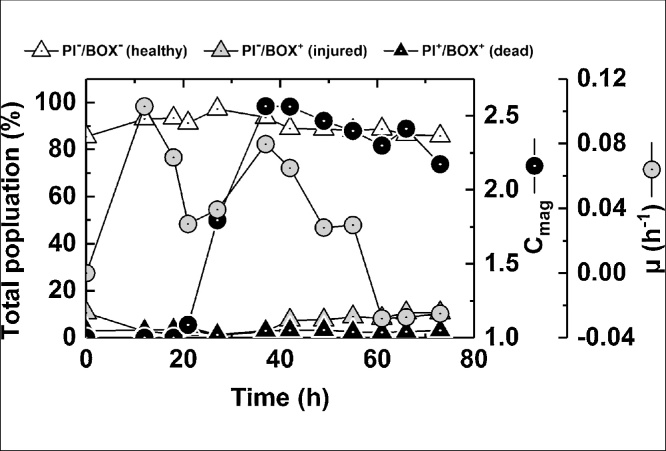
Assessment of bacterial physiology using FCM. Bacteria from an oxygen-limited pH-stat culture with 200 g·L−1 lactic acid and 6 g·L−1 sodium nitrate in the feed were stained with PI and BOX and analyzed by FCM. The percentages of cells within three differently stained populations, i.e. PI-/BOX- (‘healthy’), PI-/BOX+ (‘injured’) and PI+/BOX+ (‘dead’), are plotted.